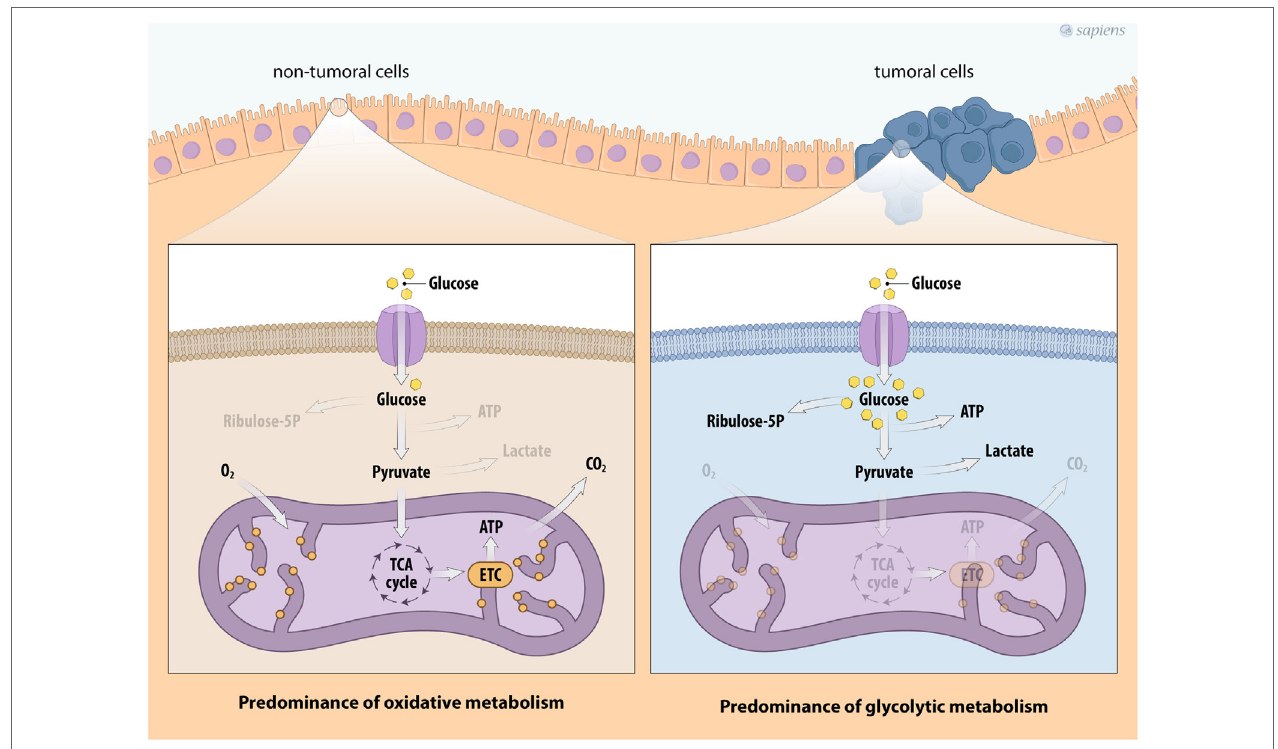
FiGURe 1 | Metabolic profile of cancer cells. Schema describing the metabolic reprogramming of tumor cells with increased glucose uptake and glycolysis that is uncoupled from oxidative phosphorylation. Cancer cell metabolism is characterized by enhanced glycolysis and the phosphate pentose pathway. This aerobic glycolytic phenotype, however, confers the generation of high amounts of lactate. Abbreviations: TCA, tricarboxylic acid; ETC, electron transport